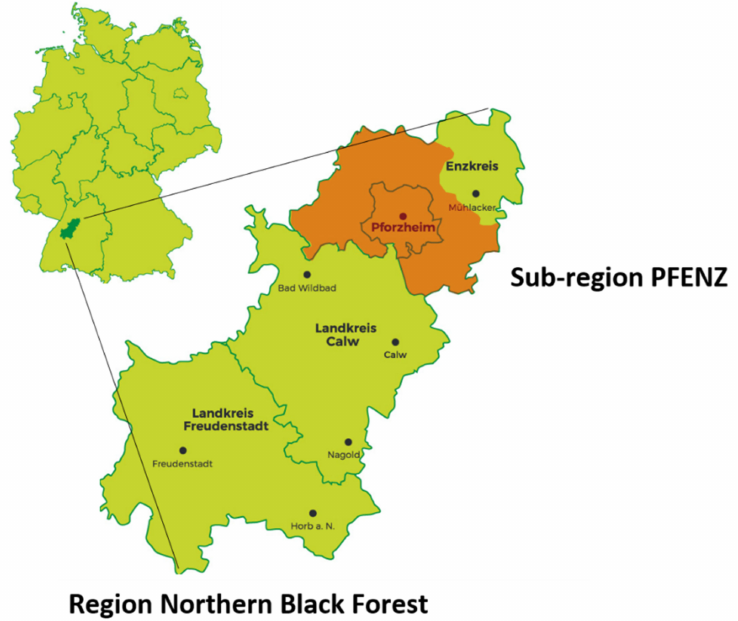
Figure 1. Location of PFENZ (figure adapted with permission from Wirtschaftsförderung Nord- schwarzwald